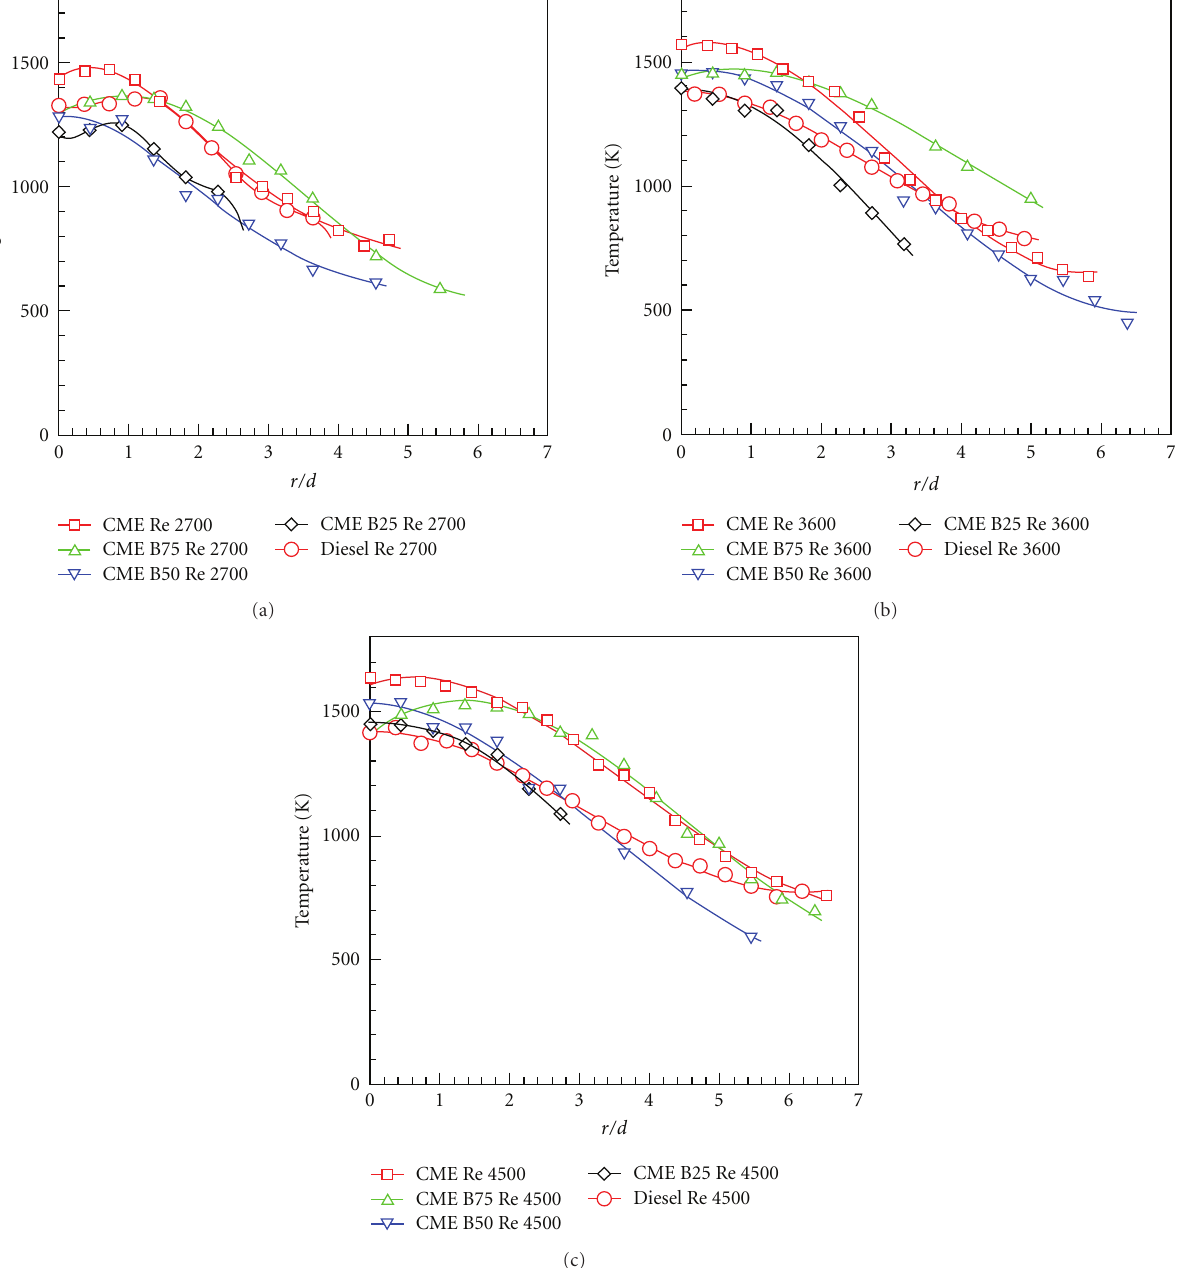
Figure 10: Radial temperature profiles of the flames at three-quarter flame